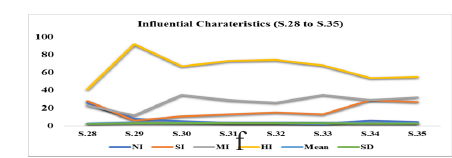
Figure 4: Influential Characteristics and their